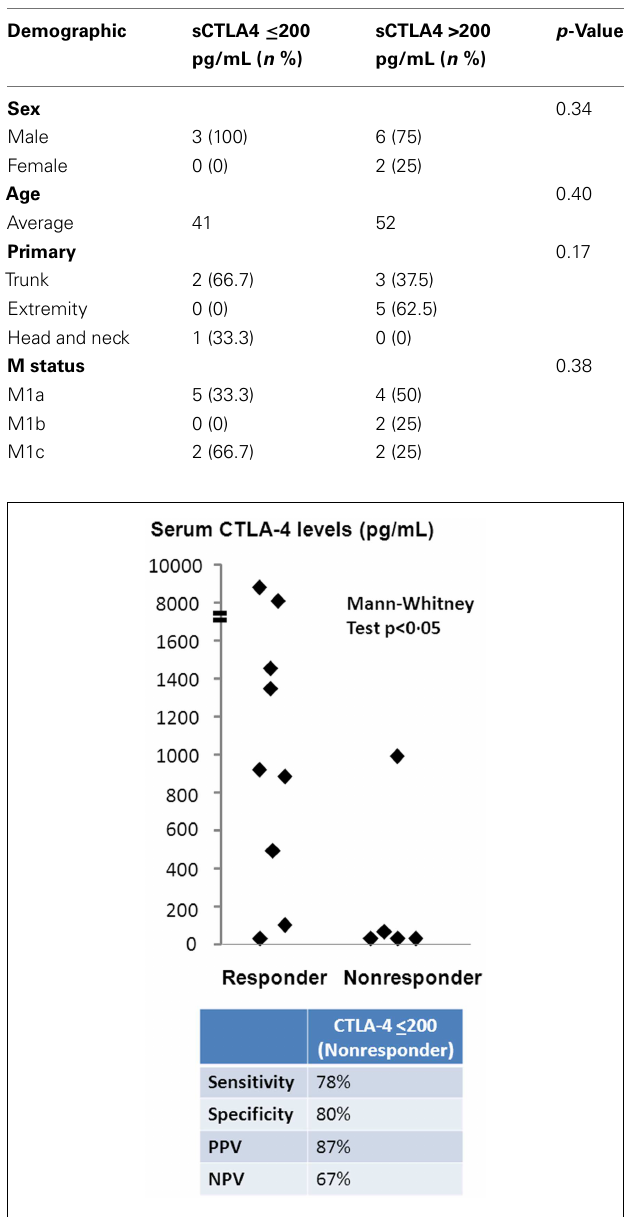
FIGURE 1 | Serum sCTLA4 levels correlate with clinical benefit to ipilimumab treatment . sCTLA4 levels were measured by ELISA and individual values plotted according to clinical response.Values are expressed as the mean value of triplicate wells.The sensitivity of the ELISA was 100pg/mL.Two-tailed Mann–Whitney test was used to evaluate the significance of the differences between patients who received ( n = 9) or did not receive ( n = 5) benefit from ipilimumab treatment.The cutoff sCTLA4 level for prediction of clinical benefit was determined using a threshold of 200pg/mL based on ROC curve analysis.